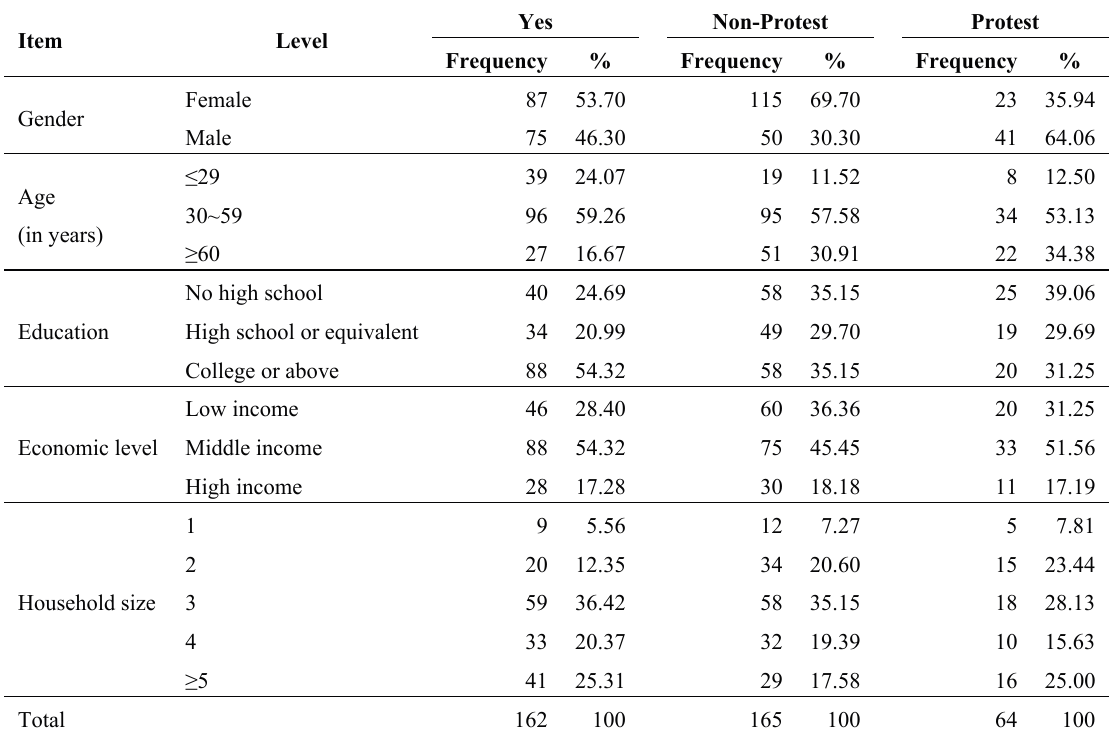
Table 4. Demographic characteristics of the yes, non-protest and protest